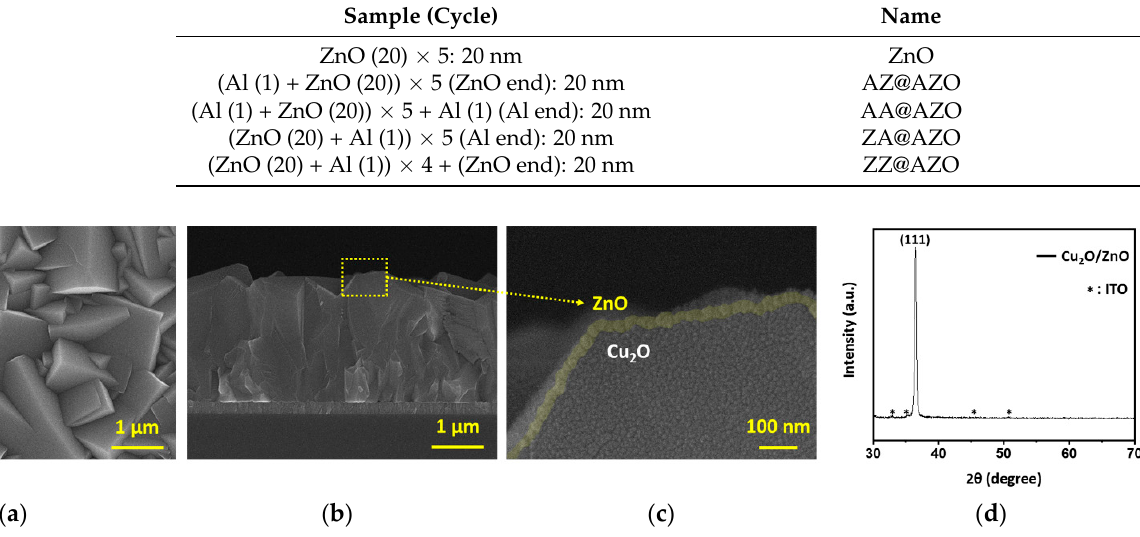
Table 1. Nomenclature used for the prepared samples.